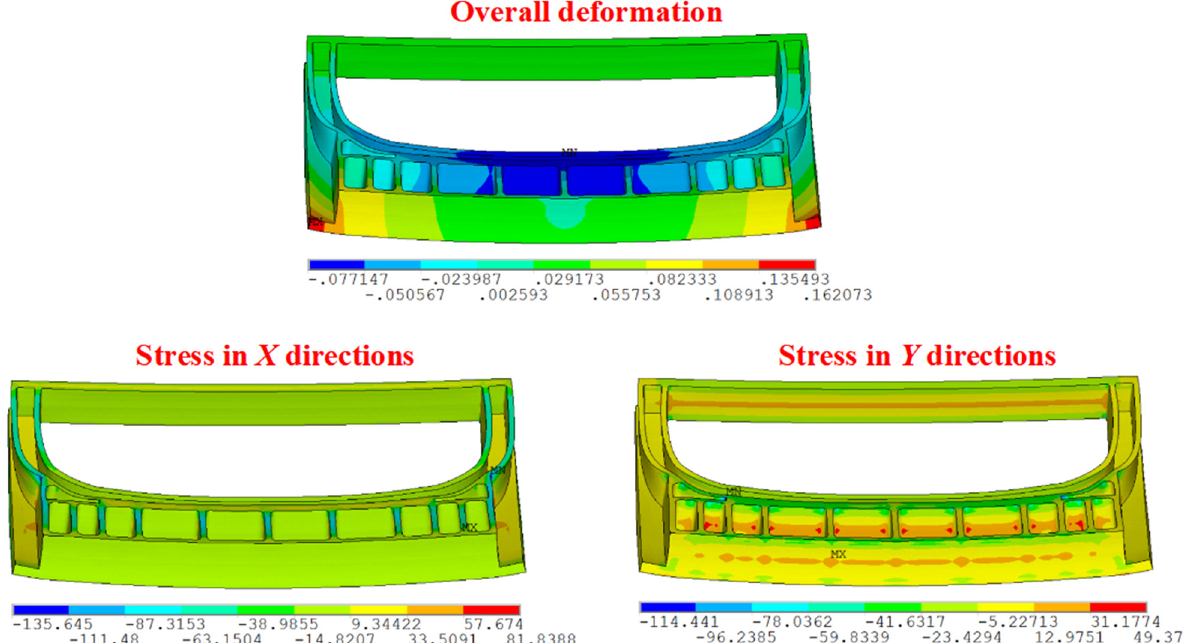
Figure 11: Simulation results of deformation and stress of Specimen B after fi rst